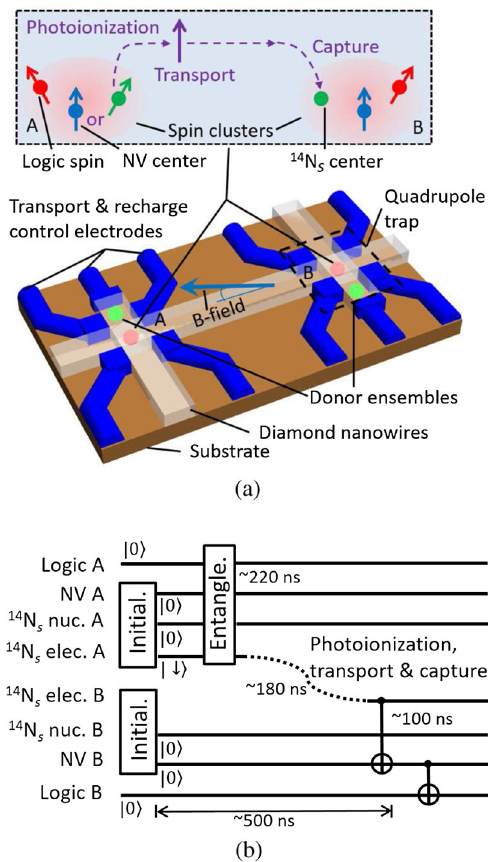
FIG. 4. (a) Sketch of two nodes of the proposed spin quantum bus network constructed from diamond nanowires (white) on top of a substrate (brown). Spin clusters A and B (red) are located at the nodes and contain logic (either the N nuclear spin of the NV center or a 13 C isotopic impurity), NV, and 14 N spins. Nearby S centers (green) for recharging the 14 N centers ensembles of N S S in the clusters are located in compartments next to the nodes. Surface electrodes (blue) are used to control electron transport between clusters and the recharge process. At each node, four of the electrodes are arranged in a quadruple configuration to aid in trapping the transport electron at the node. A magnetic field ( B field) defines the spin quantization axis and is aligned with the (assumed identical) axes of the NV centers. For clarity, optical, microwave, and magnetic control structures have not been included in the sketch. (b) The proposed protocol to generate entanglement between the logic qubits located in clusters A and B. See text for details of the